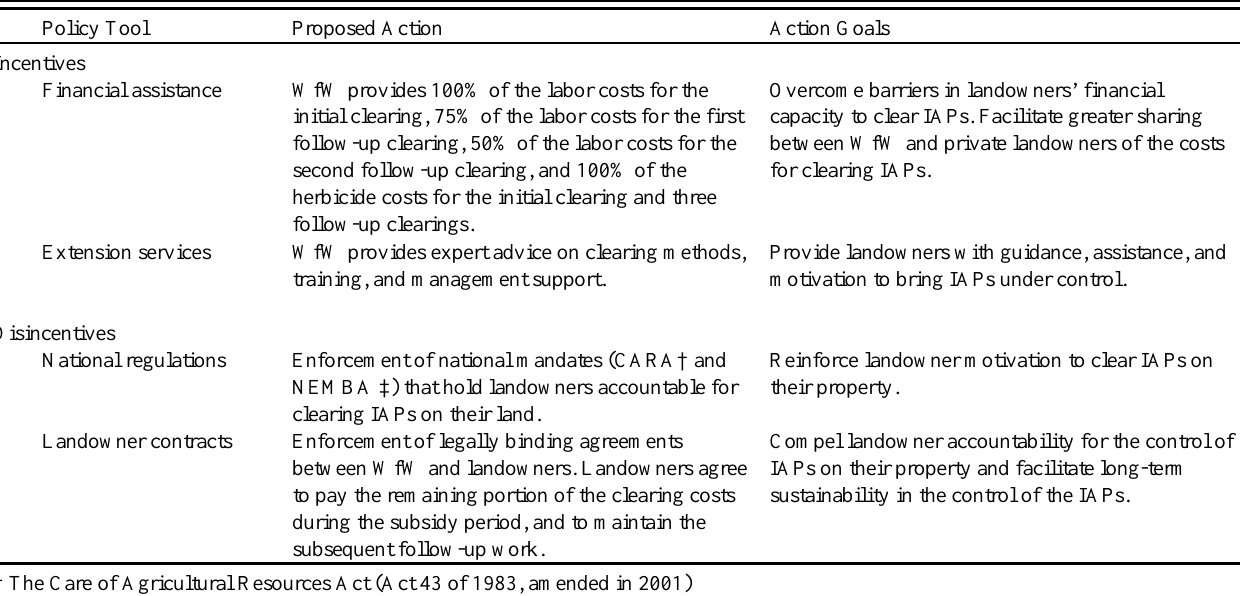
Table 1 . Summary of Working for Water’s (WfW) proposed approach to clear invasive alien plants (IAPs) on private land in the Western Cape, South